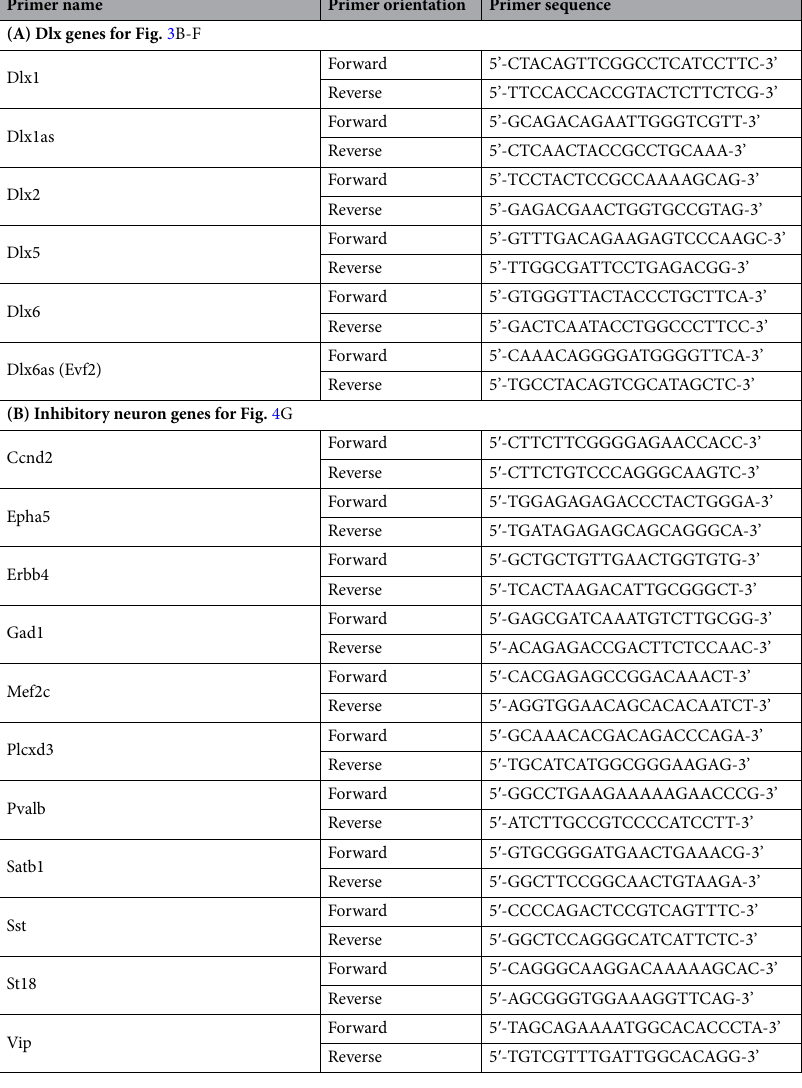
Table 2. Primers used for